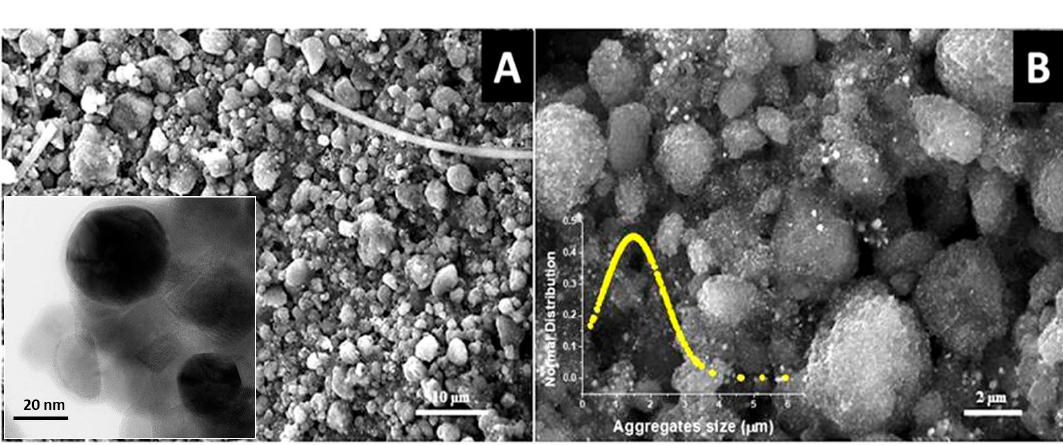
Figure 2. SEM micrographs of PAS4mg at 1700 × ( A ) and 7000 × ( B ) magnification showing an almost complete coverage of the quartz fibers with Au@TiO 2 NPs and micrometric aggregates on the top. Inset ( A ) shows a HR-TEM micrograph of the powder; inset ( B ) depicts the normal distribution of the diameter size of the